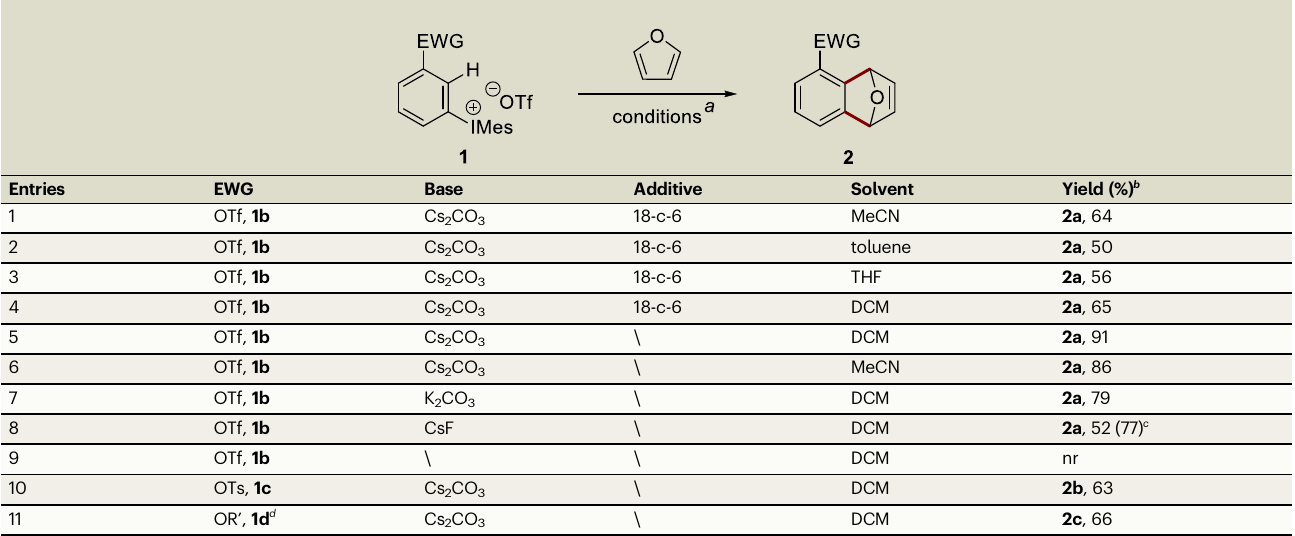
Table 1 | Optimization of reaction conditions